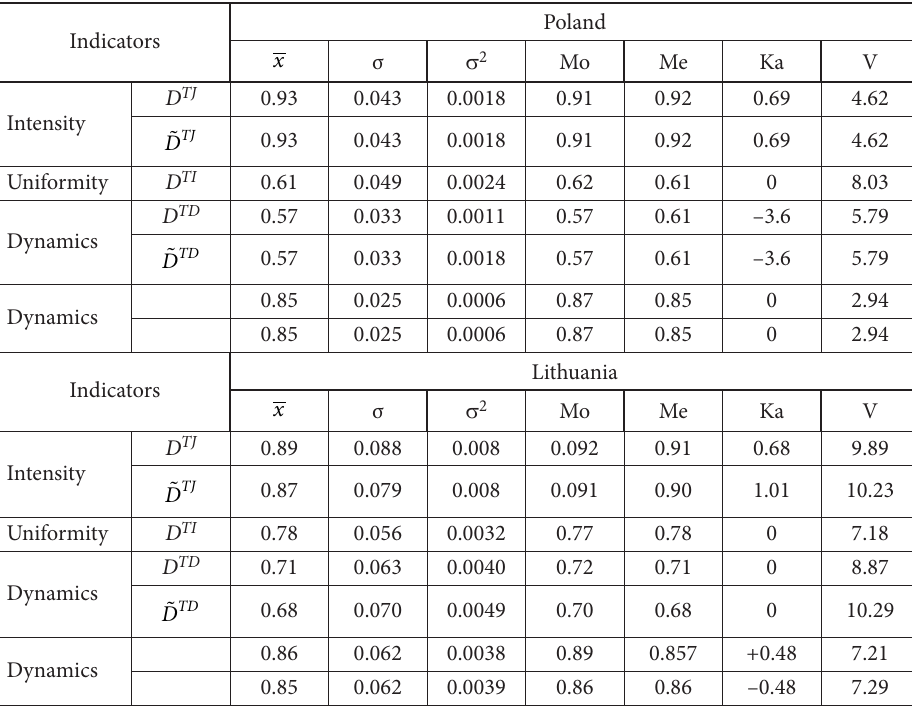
Table 10. Means of statistical characteristics of economic development indicators of Polish and Lithu- anian regions in 2008–2017 (source: compiled by authors) Indicators